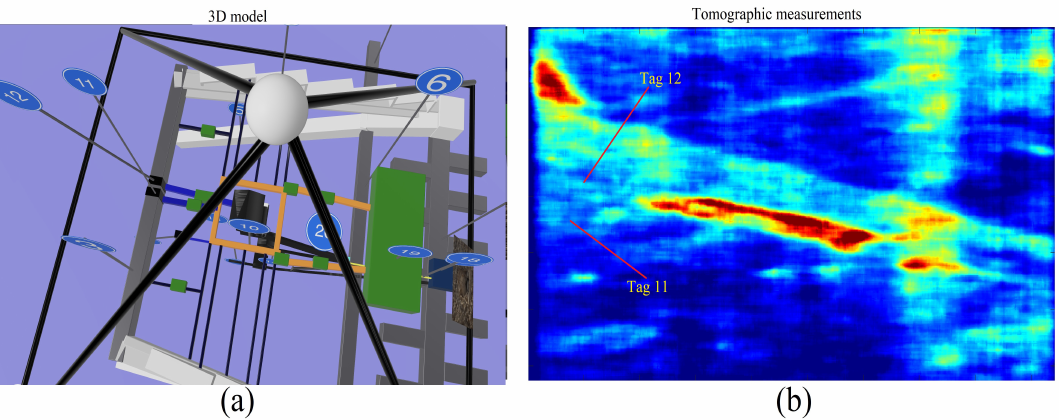
Figure 49. Tags association from tomography to 3D model. ( a ): Three-dimensional (3D) model of Khnum-Khufu. ( b ): Tomographic reconstruction (magnitude).